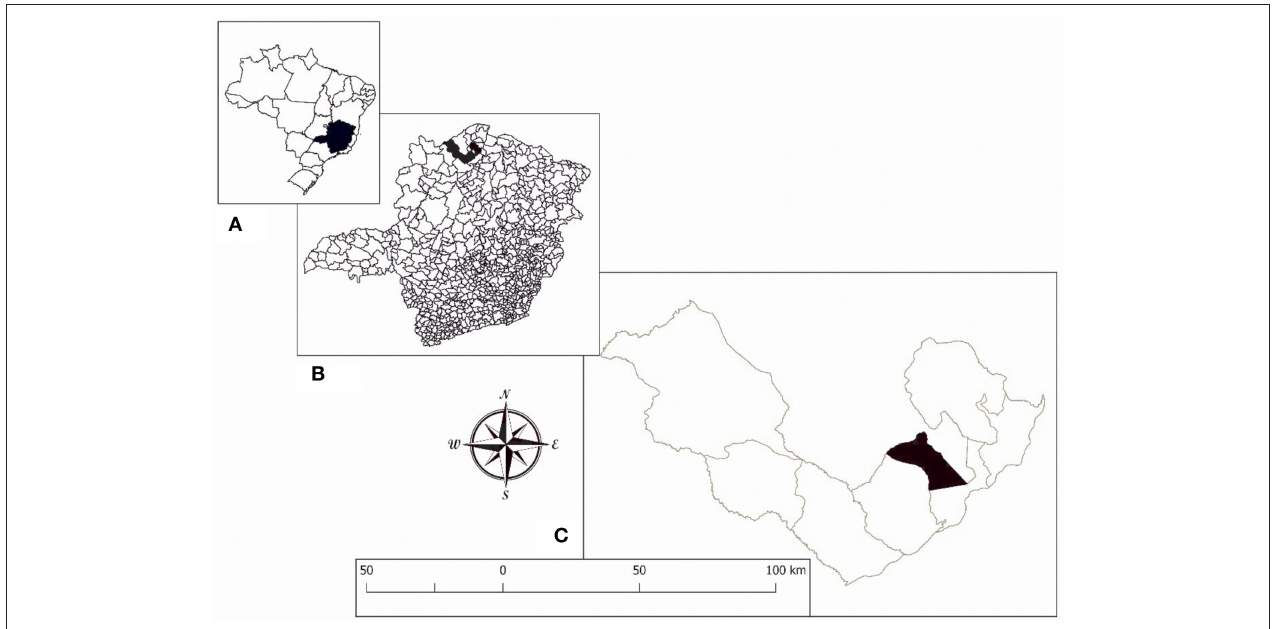
FIGURE 1 | Location of the study area. (A) State of Minas Gerais in Brazil. (B) Municipality of Januária. (C) District of Brejo do Amparo.